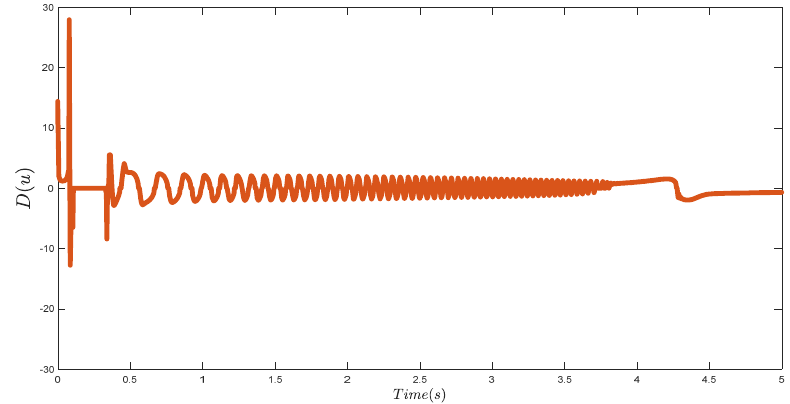
Figure 8. The output tracking performance y and error